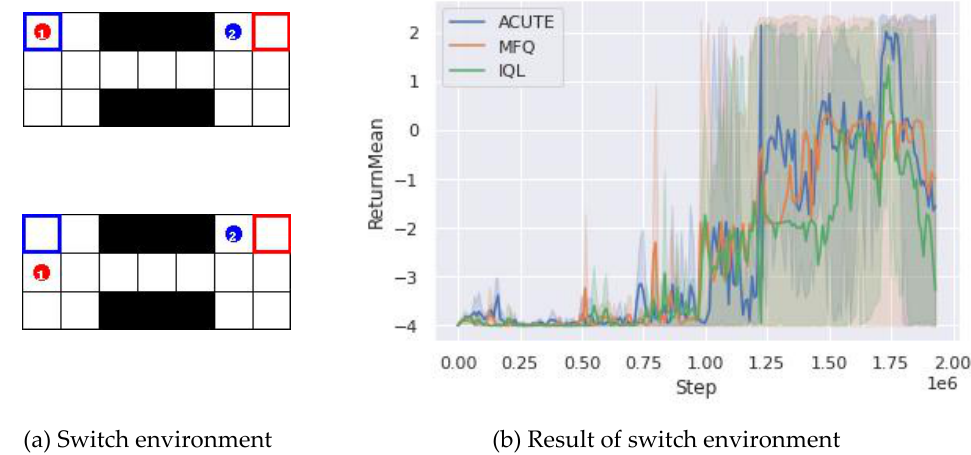
Figure 4. Sample and experiment result in ma-gym: